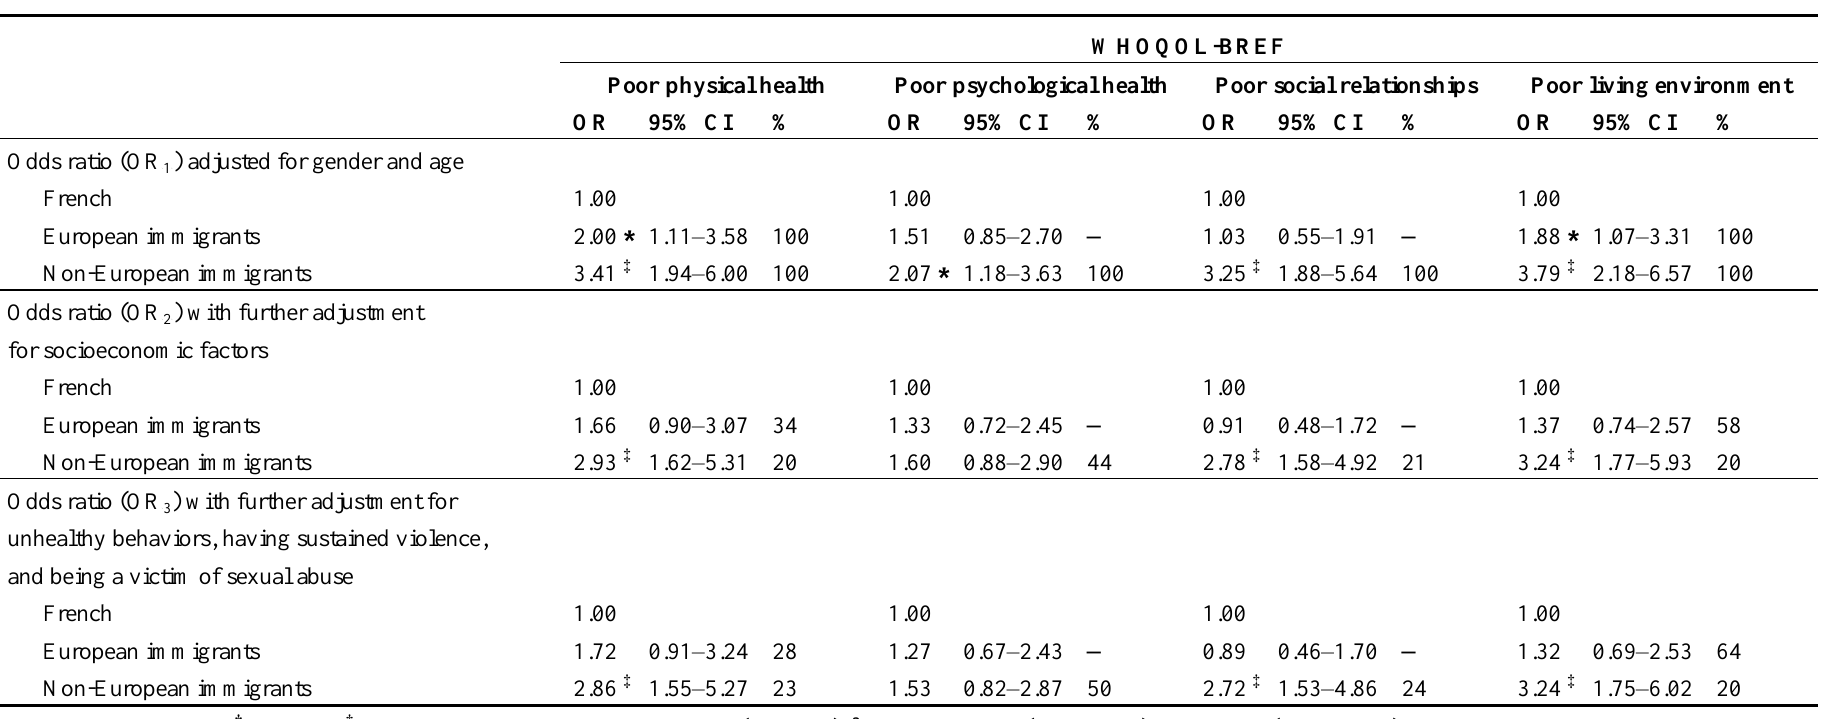
Table 4. Associations of WHOQOL-BREF and nationality and role of socioeconomic, unhealthy behaviors and violence: odds ratio (OR), 95% confidence interval (CI), and contribution of covariates (%)